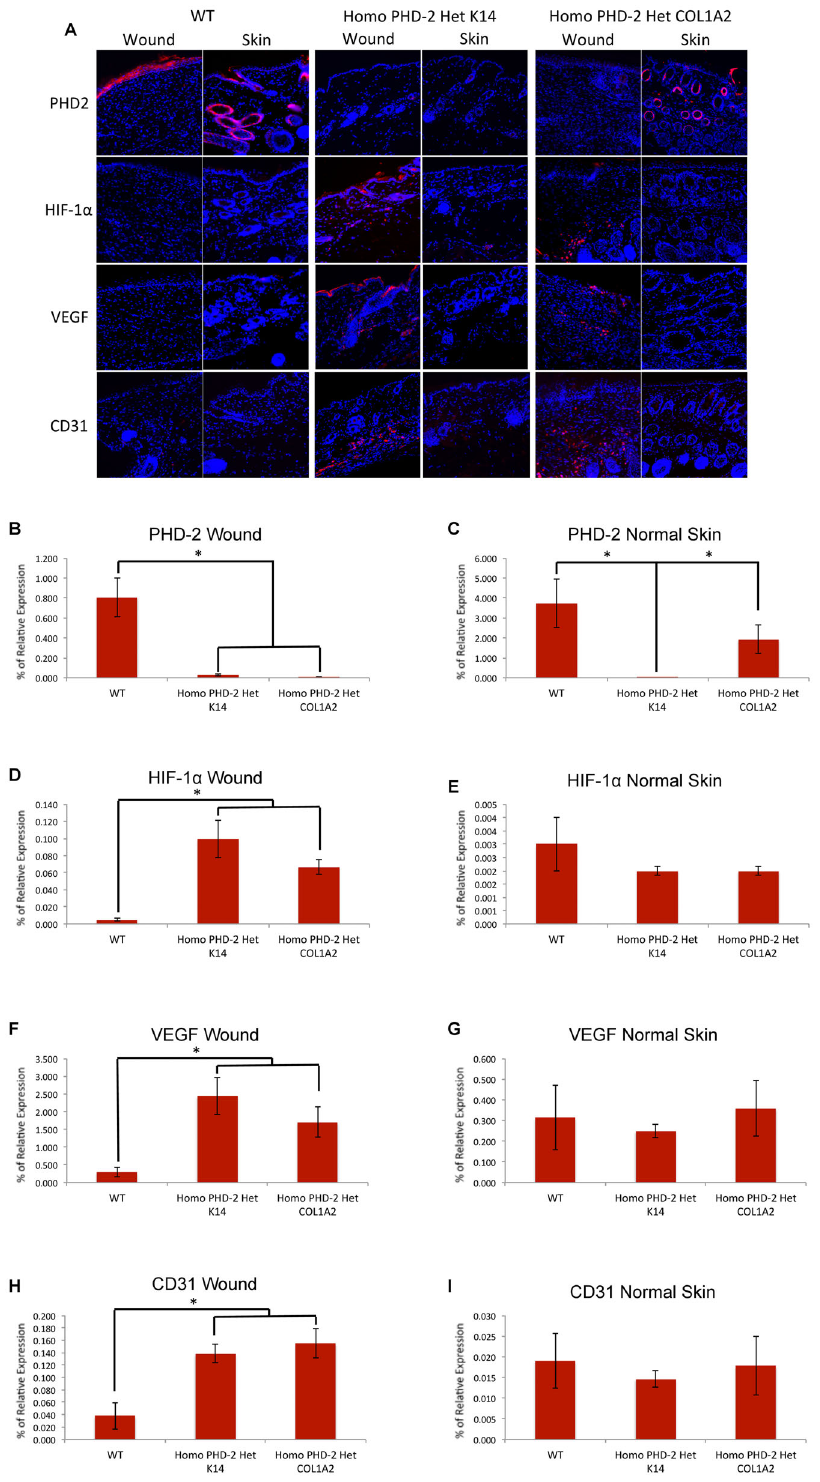
Figure 4. Immunofluorescence of wounded tissue and normal unwounded skin. A ) Representative images for immunofluorescent staining of PHD-2, HIF-1 a , VEGF, and CD31 on healed wounded skin and adjacent normal unwounded skin of wild type, heterozygous K14-Cre/homozygous floxed PHD-2, and heterozygous Col1 a 2-Cre-ER/homozygous floxed PHD-2 mice at 400 6 magnification. B ) Relative protein immunolocalization of PHD-2 in healed wounds of wild type, heterozygous K14-Cre/homozygous floxed PHD-2, and heterozygous Col1 a 2-Cre-ER/homozygous floxed PHD-2 mice (*p , 0.05). C ) Relative protein immunolocalization of PHD-2 in adjacent normal unwounded skin of wild type, heterozygous K14-Cre/ homozygous floxed PHD-2, and heterozygous Col1 a 2-Cre-ER/homozygous floxed PHD-2 mice (*p , 0.05). D ) Relative protein immunolocalization of HIF-1 a in healed wounds of wild type, heterozygous K14-Cre/homozygous floxed PHD-2, and heterozygous Col1 a 2-Cre-ER/homozygous floxed PHD- 2 mice (*p , 0.05). E ) Relative protein immunolocalization of HIF-1 a in adjacent normal unwounded skin of wild type, heterozygous K14-Cre/